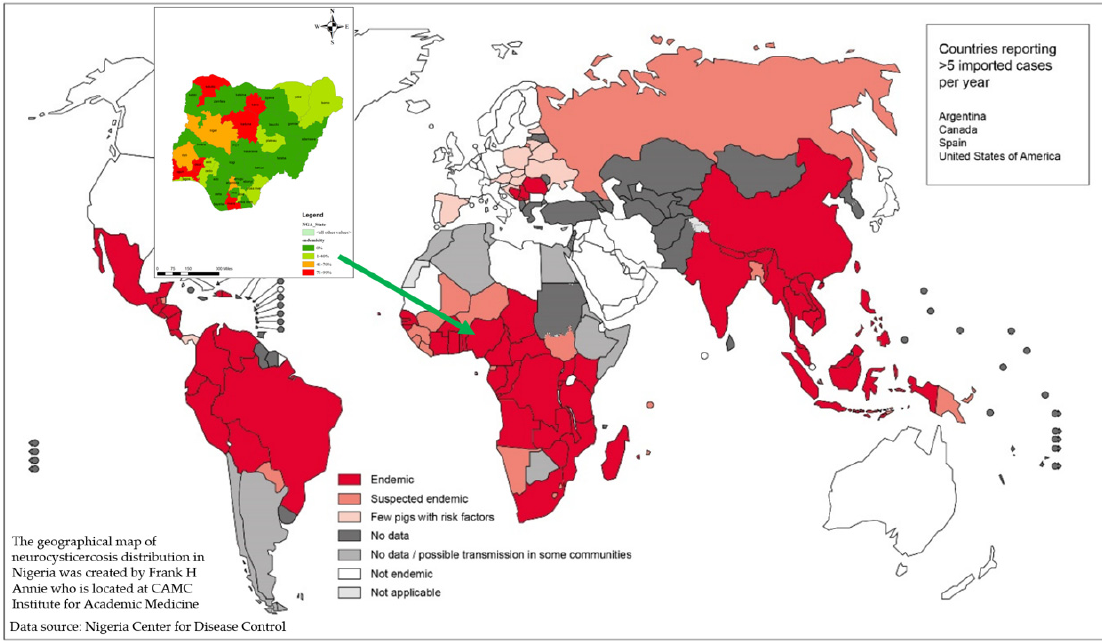
Figure 5. WHO and NCDC T. solium map depicting endemic regions in the world and in Nigeria, re- spectively [6,12]. Reprinted with permission from ref. [6]. Copyright 2016 World Health Organization and 2018 Nigeria Center for Disease